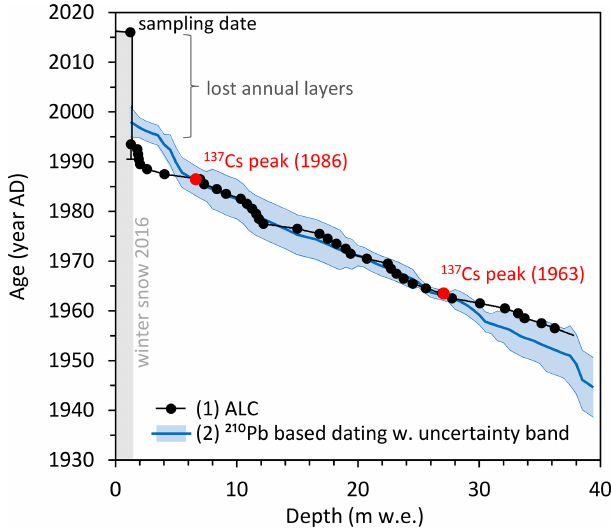
Figure 5. Synoptic graphic showing the ADA16 age–depth rela- tionship independently derived from (1) ALC using pollen and rBC concentrations in combination with the distinct time markers from the nuclear accident of Chernobyl (1986) and the nuclear surface bomb testing maximum (1963) identified by peaks in 137 Cs activity and (2) based on 210 Pb (i.e. the age–depth scale with uncertainty of the Silvretta ice core transferred to ADA16; see